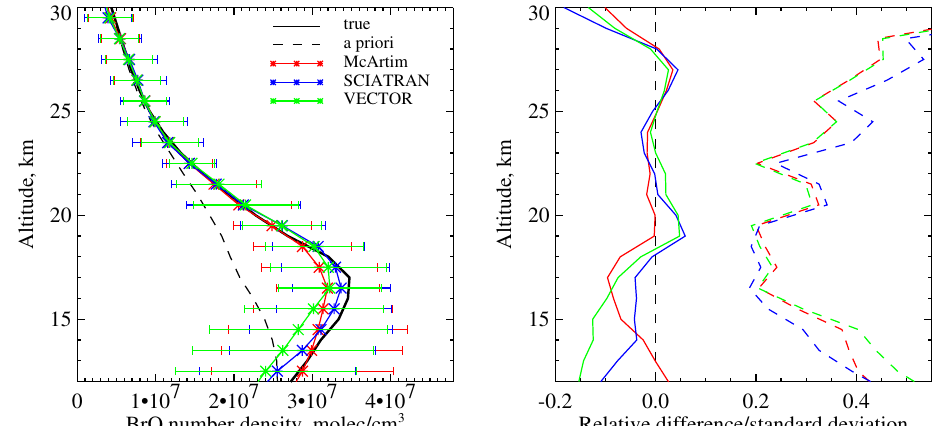
Fig. 11. Same as in Fig. 10 but retrieved with the MPI Mainz